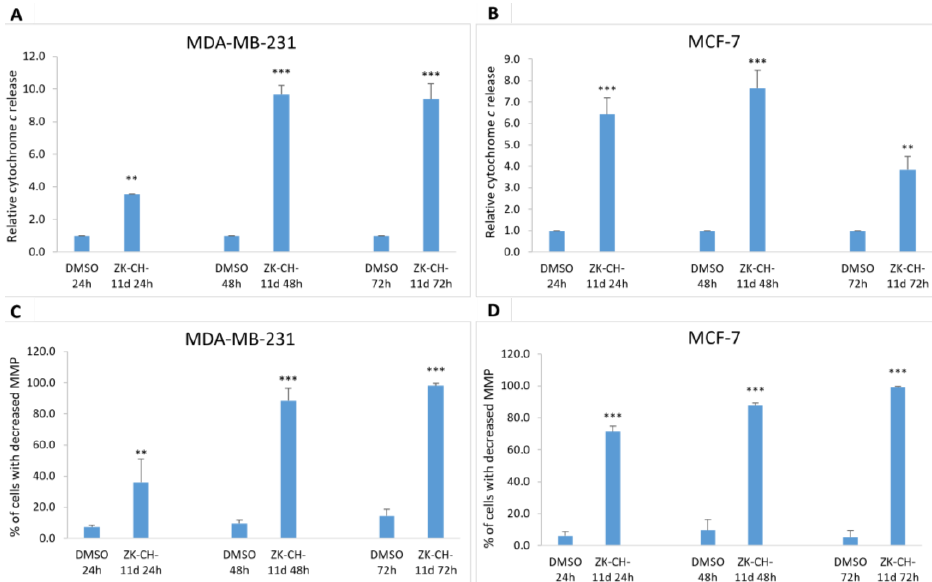
Figure 10. Analysis of changes in mitochondrial functions in MDA-MB-231 and MCF-7 tumor cells after treatment with chalcone ZK-CH-11d at a concentration of 40 µ mol/L. Relative cytochrome c release in MDA-MB-231 ( A ) and MCF-7 lines ( B ), and changes in mitochondrial membrane potential (MMP) in MDA-MB-231 ( C ) and MCF-7 ( D ) cells after chalcone treatment after 24, 48, and 72 h. The values shown are the mean of three independent experiments compared to the control (DMSO). Statistical significance: ** p < 0.01, *** p < 0.001.